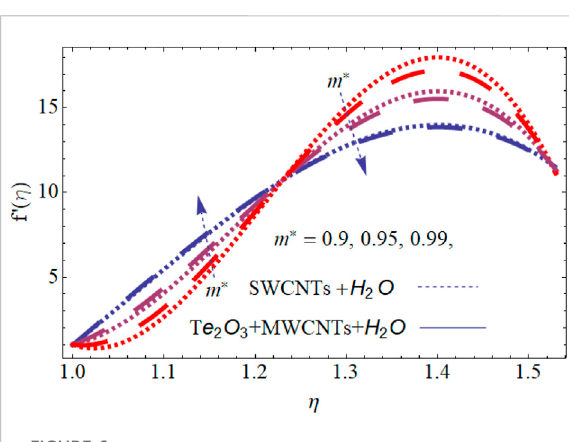
FIGURE 6 Inspiration of Marangoni convection on the velocity pro fi